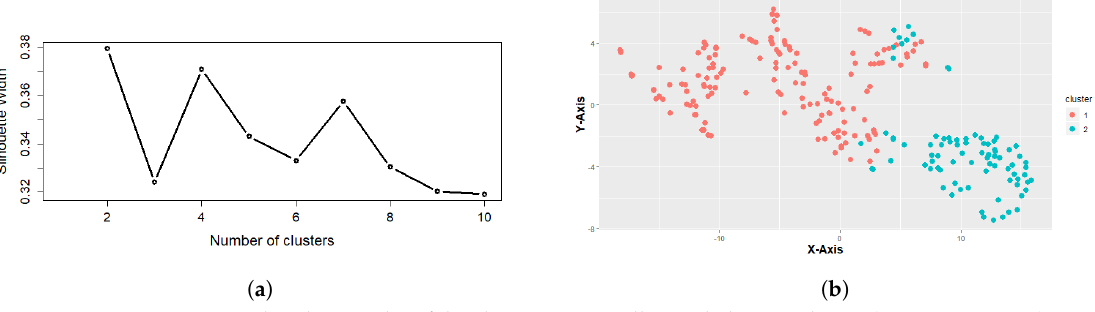
Figure 11. Data considered is Level-3 of the clustering tree, all cases belong to class-B (PSTN customers). ( a ) Curve of average silhouette width to identify optimal number of clusters; ( b ) Plot showing separation of cases with optimal number of clusters identified, two in this case.